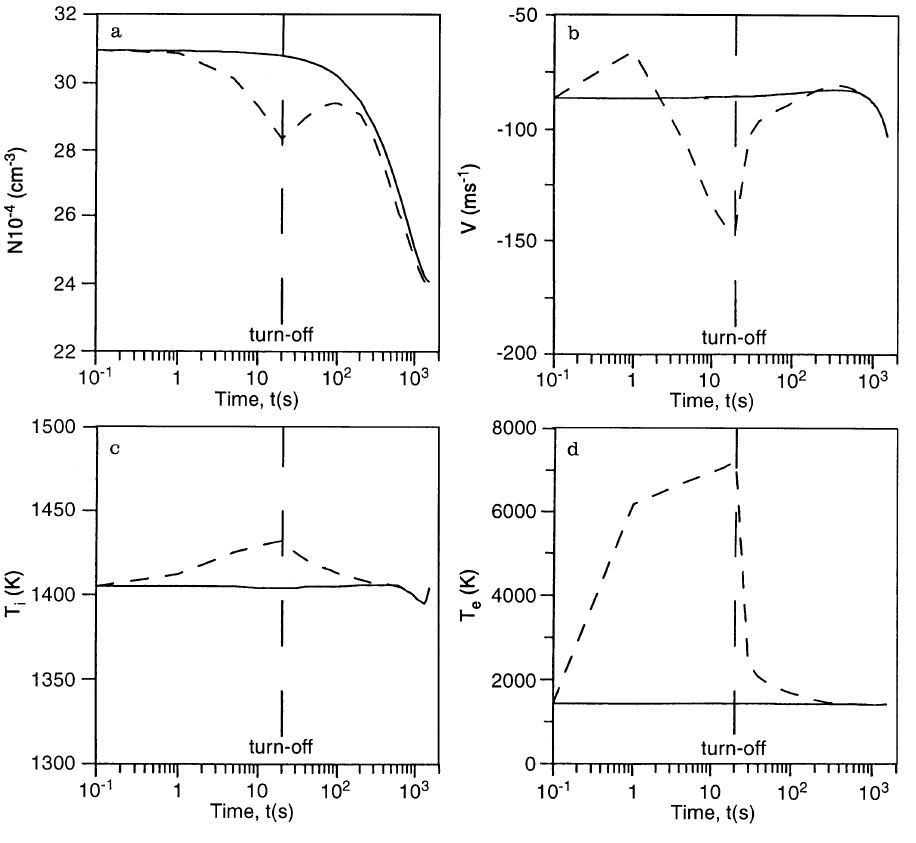
Fig. 4. a The time variations of electron concentration, b parallel component of the positive ion velocity, c ion temperature, d electron temperature, at level h " 316 km after turn-on of the HF heater ( dashed line ). Solid lines present the ‘‘unheated’’